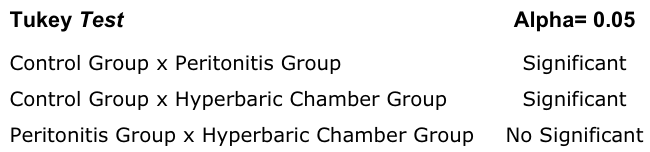
TABLE 2 - Comparison among groups by Tukey Test Tukey